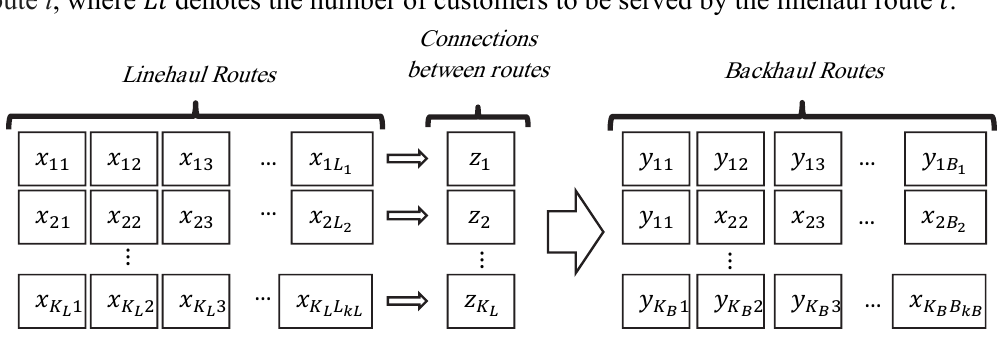
Fig. 1. Encoding of one alternative of solution